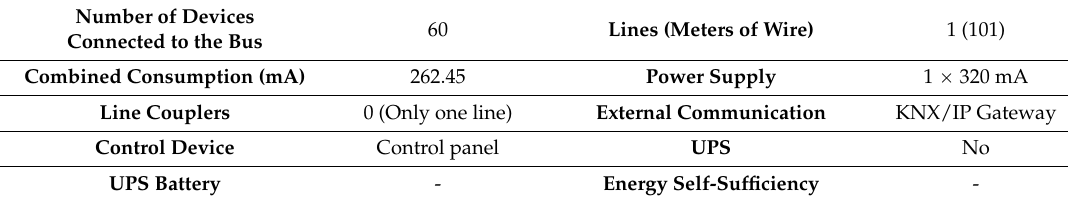
Table 5. General features of intermediate home automation system.